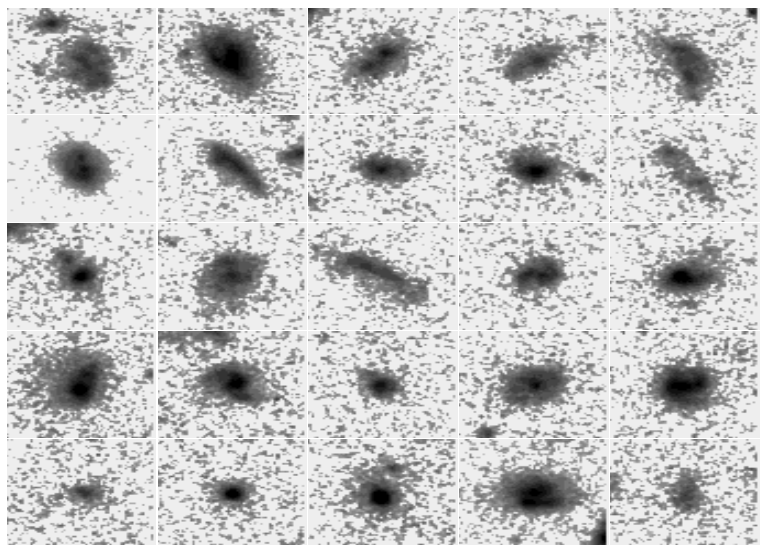
Fig. 5. HST/WFC3 J -band images of ULIRGs at 1 < z < 1 : 8 from the COSMOS field of the 3D-HST survey. The size of each image is 4 ′′ (cid:2) 4 ′′ .